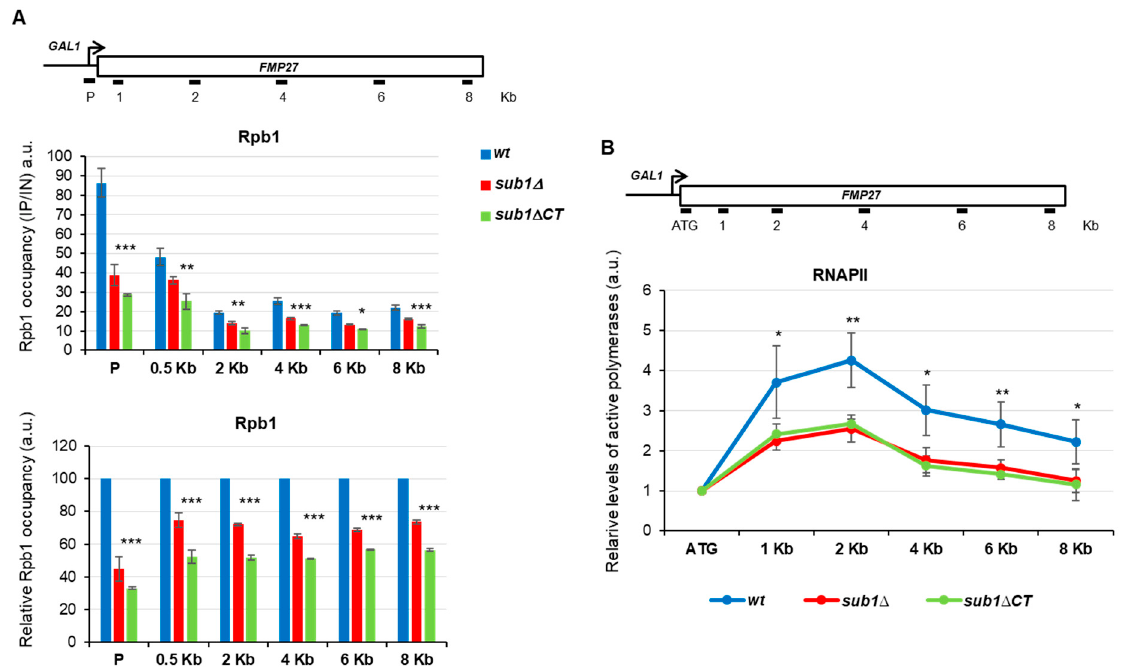
Figure 4. Decreased association of Rpb1 with chromatin and active elongation ‐ competent RNAPII in sub1 Δ CT cells during active transcription. ( A ) The upper panel is a schematic representation of the GAL1 ‐ FMP27 gene; the PCR primer pairs, corresponding to the promoter and coding regions at the specified positions used in the ChIP assays, are indicated. The middle panel depicts the ChIP analysis of Rpb1 association with the FMP27 gene upon galactose ‐ induction in wt , sub1 Δ , and sub1 Δ CT cells; qPCR quantifications are shown in the graph, where the numbers on the Y ‐ axis represent the ratio of the values obtained from specific primer products to the negative control (intergenic region of chromosome VII) and are normalized to the input controls. The bottom panel shows the relative Rpb1 occupancy within FMP27 ; qPCR values obtained for each analyzed gene region in mutant cells, sub1 Δ and sub1 Δ CT , were normalized to wt values, which were set to 100. ( B ) Transcriptional run ‐ on (TRO); the upper panel is a diagram of the GAL1 ‐ FMP27 gene, where locations of the probes used in the TRO assay are indicated. The lower panel shows the levels of active competent RNAPII from the TRO assay in wt , sub1 Δ , and sub1 Δ CT cells growing in a galactose ‐ containing medium. After normalization for the 18S rRNA signal, the results were normalized to the ATG probe, which was fixed at 1, and plotted. Error bars represent standard deviations. Statistically significant levels are shown (ns = non ‐ significant, * = p < 0.05, ** = p < 0.01, ***= p < 0.001).